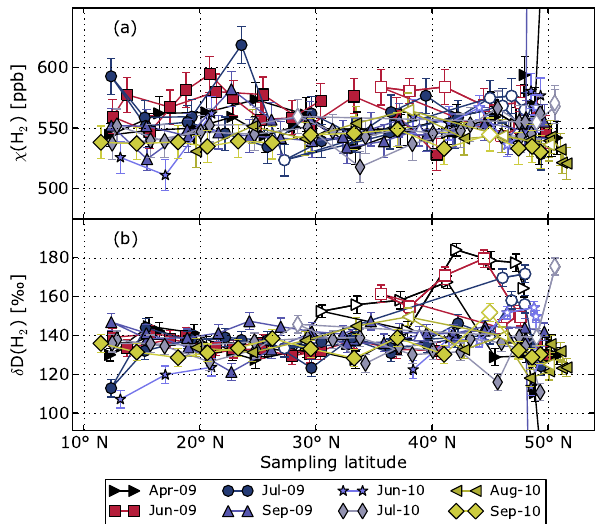
Fig. 2. Latitudinal distribution of χ( H 2 ) (a) and δ D (b) data from samples that were collected on flights to Caracas, Venezuela. Strato- spheric samples are indicated with open symbols. Two (polluted) samples are off the